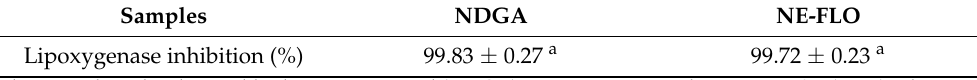
Table 6. Anti-inflammatory activity of NE-FLO assessed using lipoxygenase inhibition